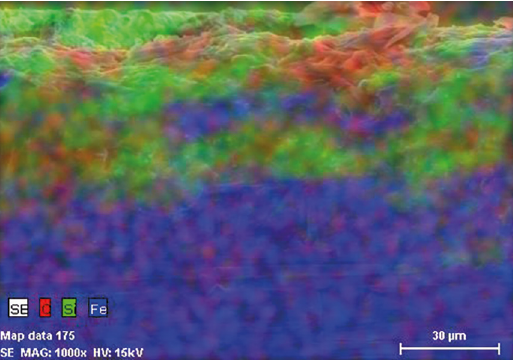
Figure 4. SEM image of the interface elemental mapping at interface.